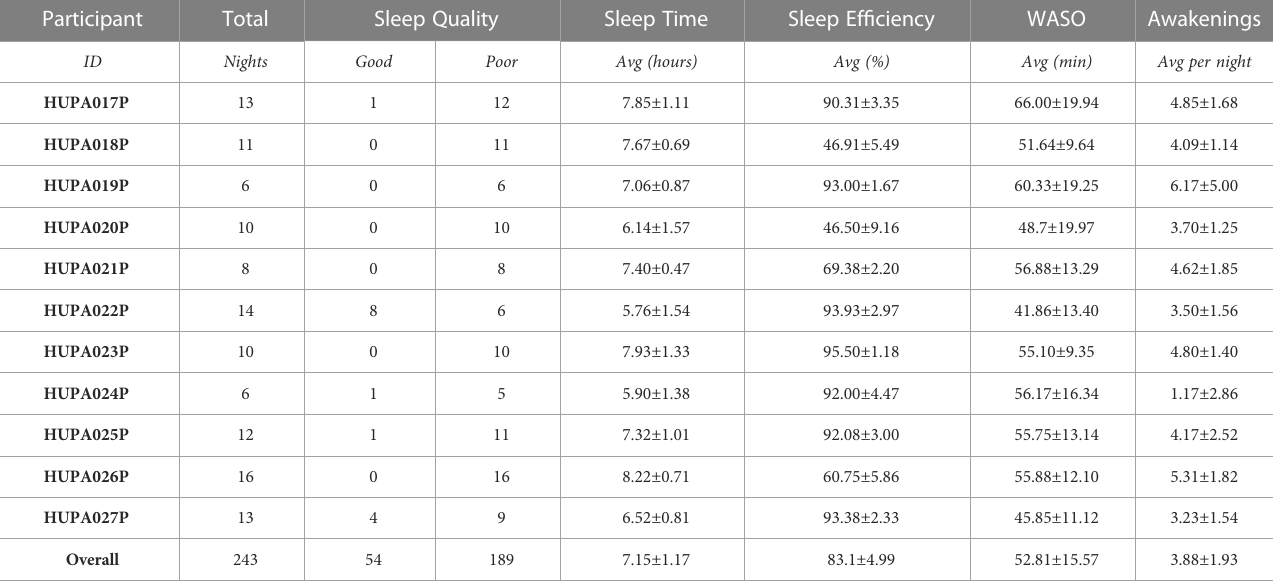
differences for Cluster 1 and Cluster 2, versus Cluster 3 and Cluster 4 in time in hypoglycemia, and for Cluster 3 versus Cluster 2 and Cluster 4 in time in hyperglycemia. Cluster 1 and Cluster 4 are also signi fi cantly different in terms of CV. For the mean of glucose values, despite Welch ’ s F-test, the pairwise tests found no signi fi cant differences. One